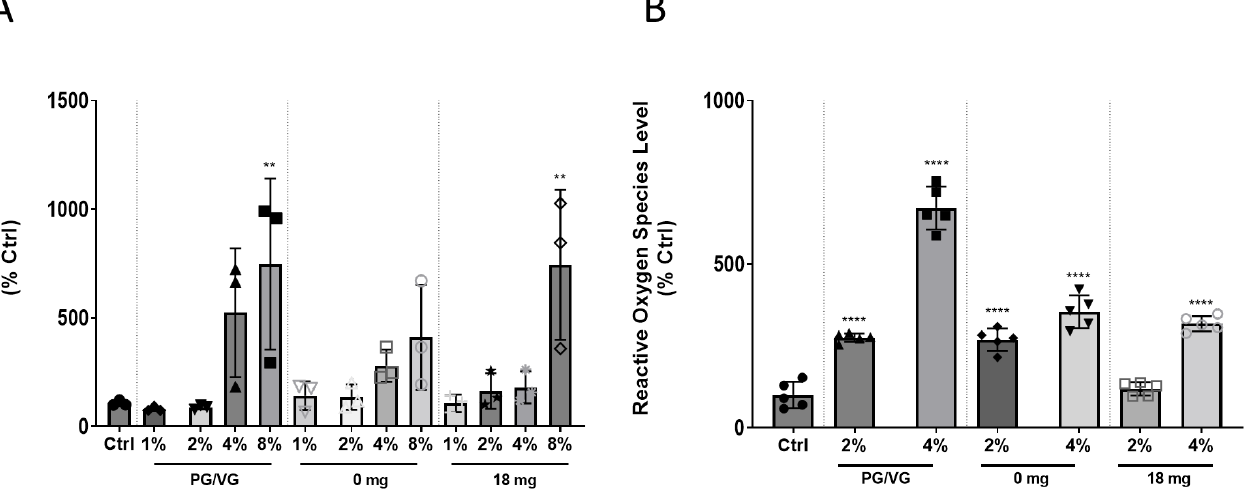
Figure 2. Reactive oxygen species levels in HCAEC after ( A ) Direct EAC exposure. ROS levels were measured in HCAEC after exposure to various concentration of EAC generated from: (i) a PG/VG standard (non-flavoured), (ii) 0 mg nicotine (tobacco flavoured), and (iii) 18 mg nicotine (tobacco flavoured) at for 24 h Data shown is expressed as a mean ± SEM (n = 3 biological replicates). ( B ) Indirect effects of EAC. A549 epithelial lung cells were exposed to EAC under the same conditions. Media from the treated A549 cells were then used to treat HCAEC on a separate plate for 24 h before a DCF assay was performed. Data shown is expressed as a mean ± SEM (n = 5 biological replicates). One-way ANOVA with Bonferroni post-tests was used for statistical analysis, ** p < 0.01; **** p < 0.0001 versus Ctrl.